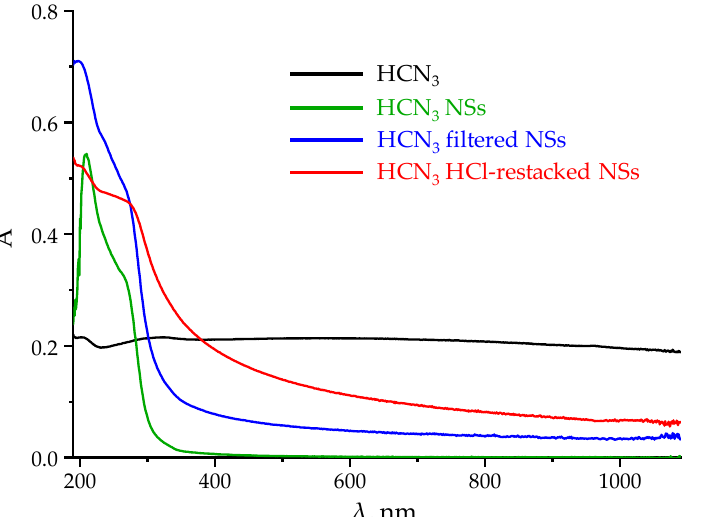
Figure 6. Typical UV-vis spectra of the suspensions of HCN 3 , its pristine as well as reassembled and redispersed nanosheets.